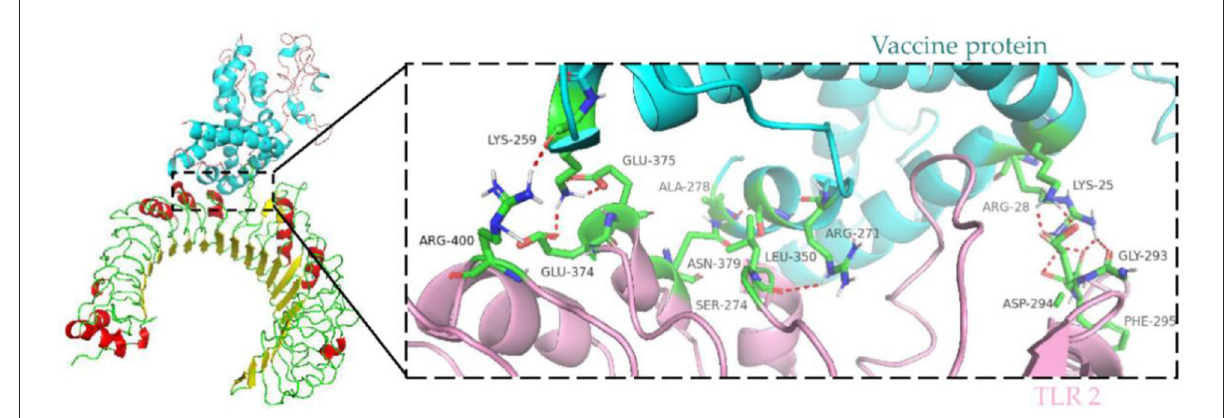
FIGURE8 Molecular docking of subunit vaccine with TLR2. Docking complex of vaccine protein and TLR2, with the vaccine protein colored sky blue and the A chain of TLR2 colored light pink. Residues with H-bond interactions are represented in the sticks model and the remaining residues are represented in the cartoon model. Hydrogen bonds are represented as red dashed lines.